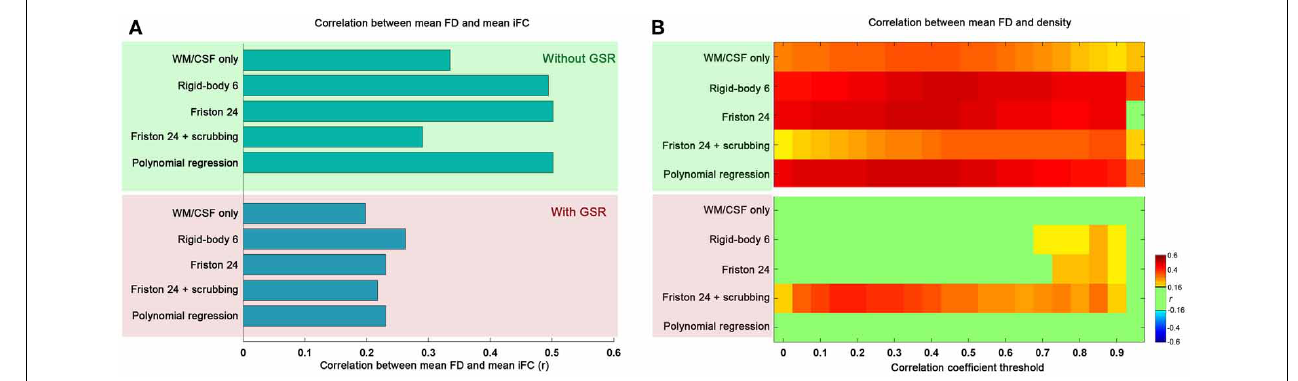
FIGURE 1 | The relationship between mean framewise displacement (FD) and mean intrinsic functional connectivity (iFC) (A) as well as density under different correlation thresholds (B). The mean iFC was averaged across all the connections between all the pairs of 90 ROIs of automated anatomical labeling (AAL) atlas. Five preprocessing